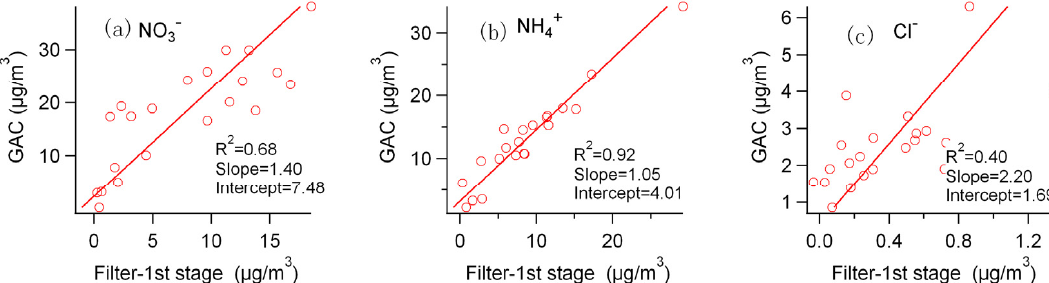
Fig. 8. Inter-comparison between the GAC-IC system and the filter measurement with data only from the 1st stage. Fig.8. Inter-comparison between the GAC-IC system and the filter measurement with measurements was 4 min and no sampling inlet was applied data only from the 1 st stage. for the